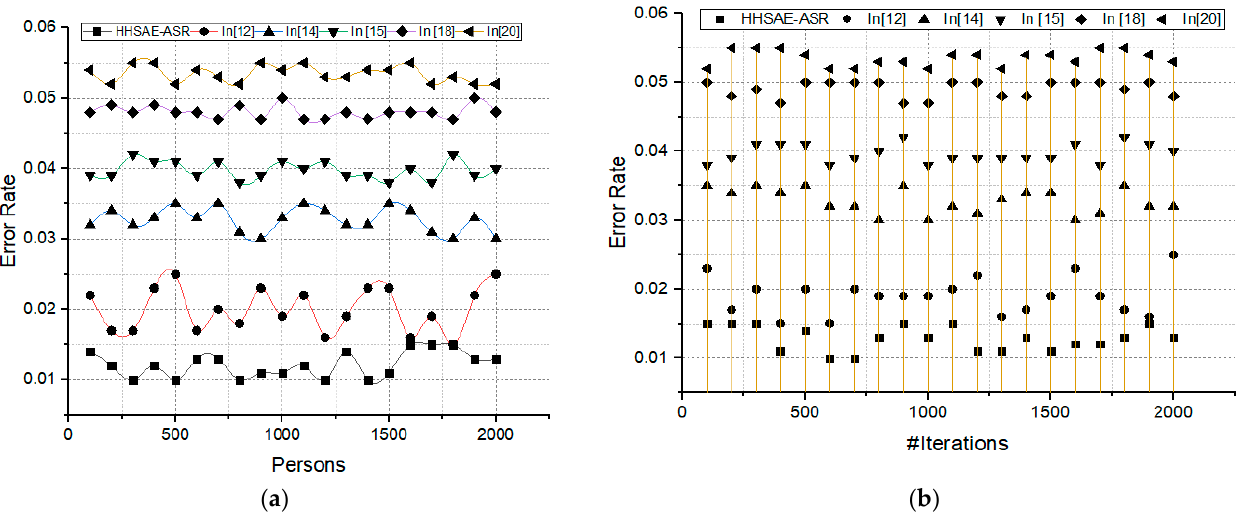
Figure 4. Error rate analysis of various numbers of persons and iterations; ( a ) The comparisons of persons and error rate; ( b ) the iterations number and error rate plot.